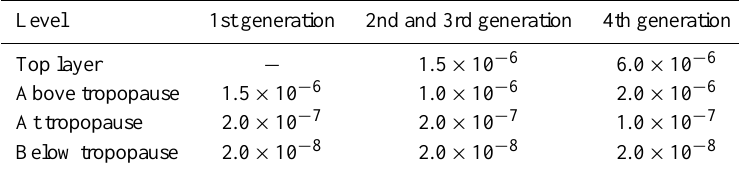
Table 6. Ozone concentrations in kg kg − 1 around the tropopause for the different generations of FAMOUS.